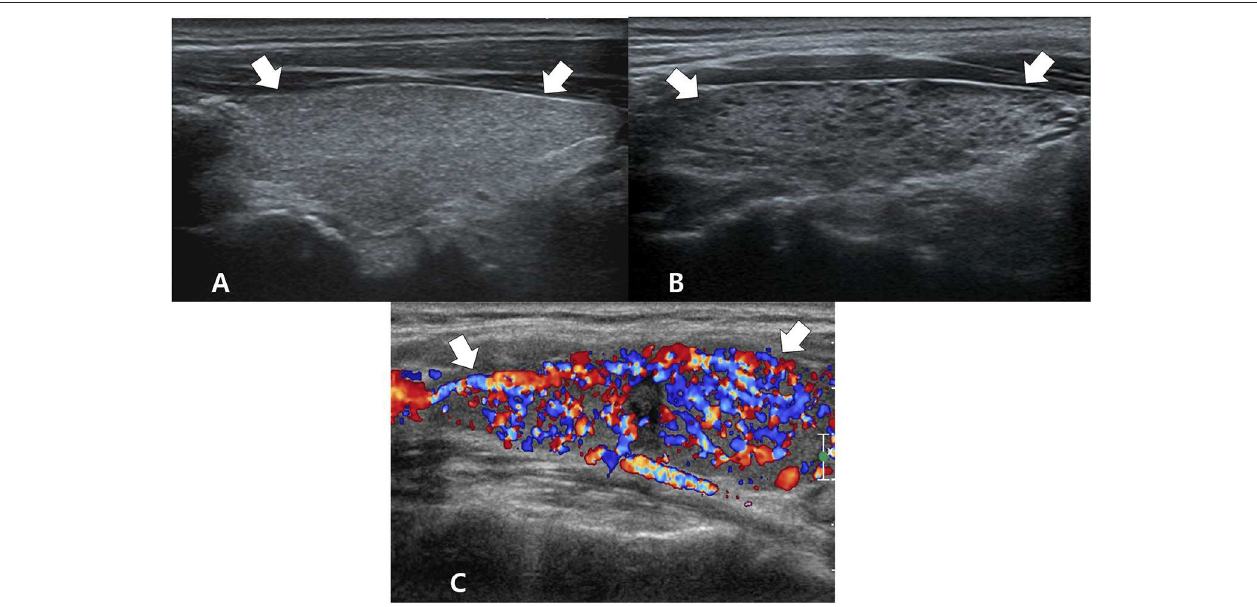
FIGURE 2 | Ultrasonography images of essential and specific features for diffuse thyroid disease: coarse echotexture (A) and micronodulation (B) on longitudinal gray-scale sonograms and thyroid inferno (with poor delineation of thyroid parenchyma due to diffuse color signals) (C) on a longitudinal color Doppler sonogram. The arrows mark the thyroid